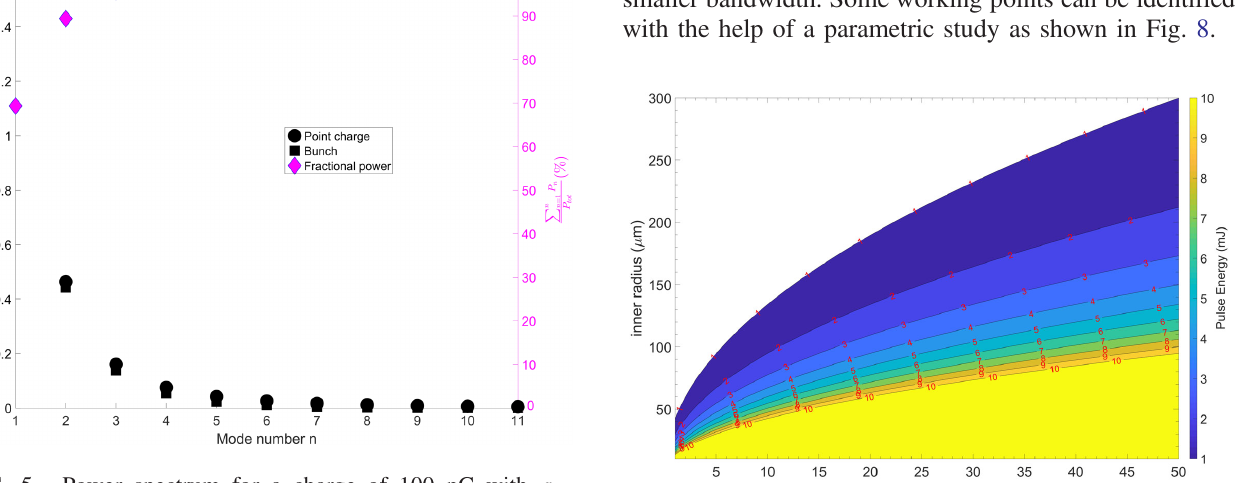
FIG. 5. Power spectrum for a charge of 100 pC with a ¼ 148 μ m and b ¼ 178 μ m. We here considered point charge (black dots), a 20 fs long Gaussian bunch (black squares) and fractional power (magenta